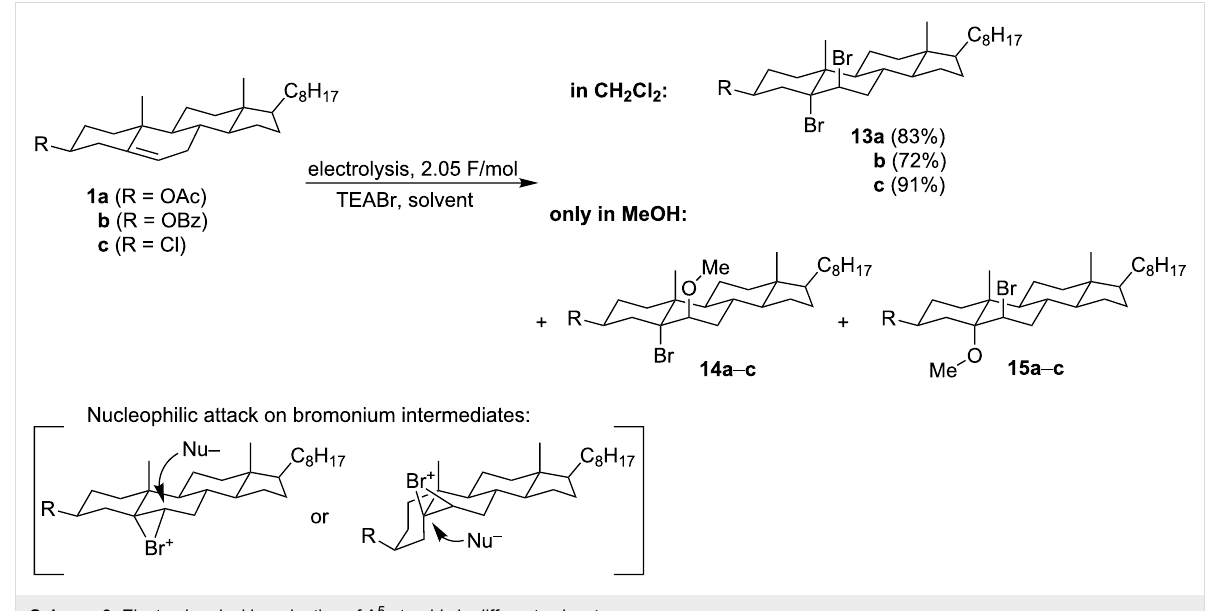
Scheme 6: Electrochemical bromination of Δ 5 -steroids in different